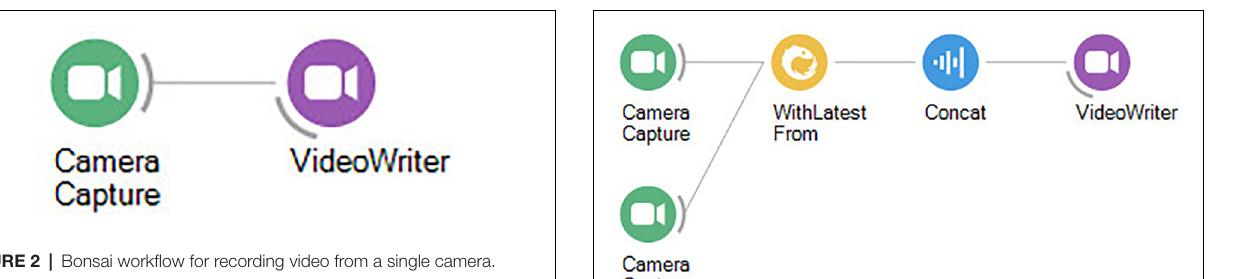
FIGURE 3 | Bonsai workflow for correlating video from two cameras